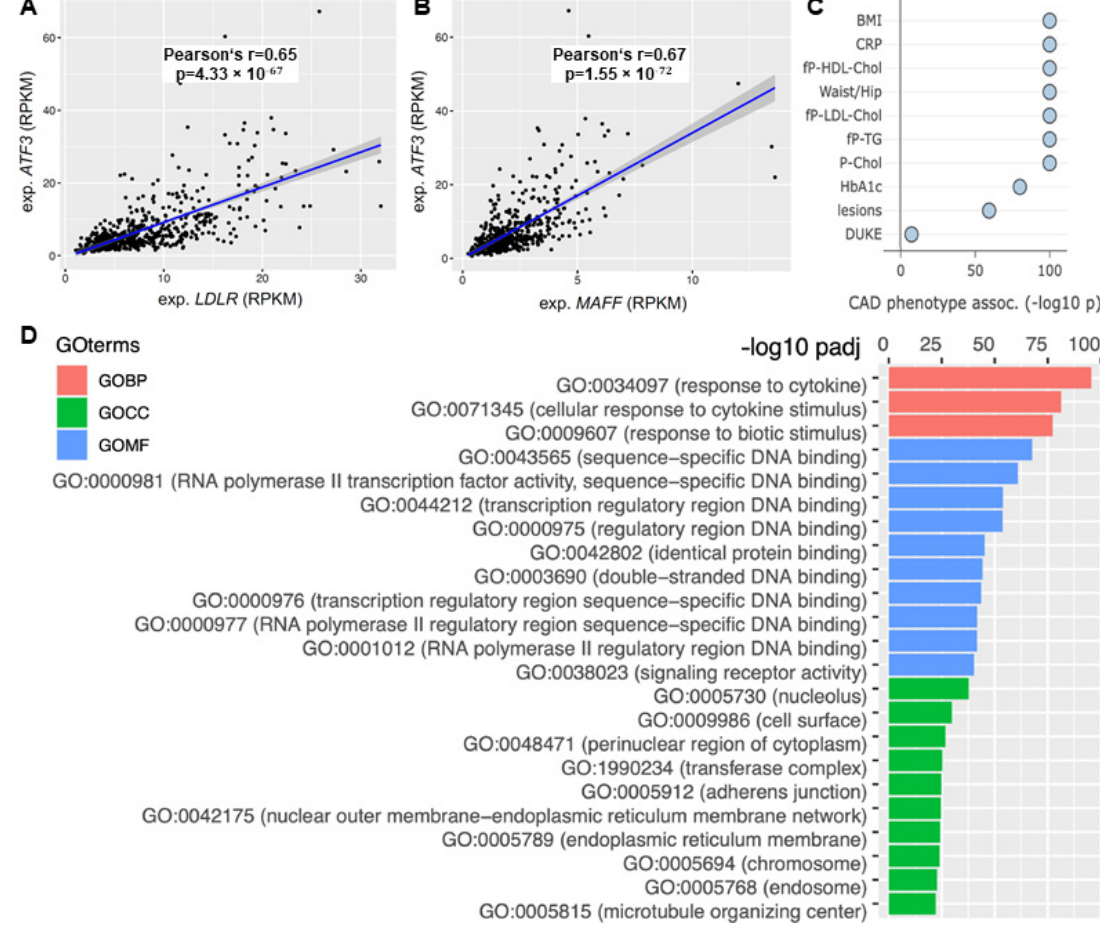
Figure 6. The role of ATF3 as a central regulator of cholesterol metabolism in the human liver. Correlation of ATF3 expression with ( A ) LDLR and ( B ) MAFF expression in STARNET. ( C ) Correlation with CAD associated phenotypes in the liver supernetwork regulated by ATF3 based on expression. ( D ) Pathway analysis based on Gene Ontology terms derived from the liver supernetwork based on expression data. Red bars represent biological pathways, green cellular compartments and blue mo- lecular functions. CAD: Coronary artery disease; GO: Gene Ontology; GOBP: Gene Ontology Bio- logical Pathway; GOCC: Gene Ontology Cell Compartment; GOMF: Gene Ontology Molecular Function; LDLR: low-density lipoprotein receptor; MAFF: MAF basic leucine zipper transcription factor F.